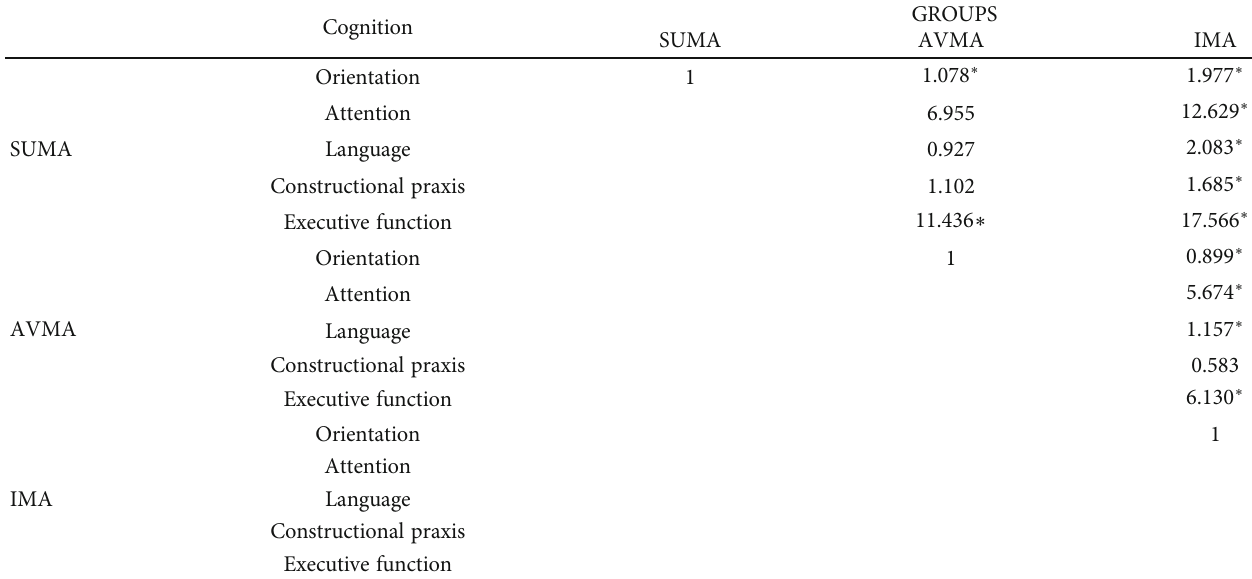
Table 3: Post hoc comparisons using Tukey ’ s HDS. Mean di ff erences